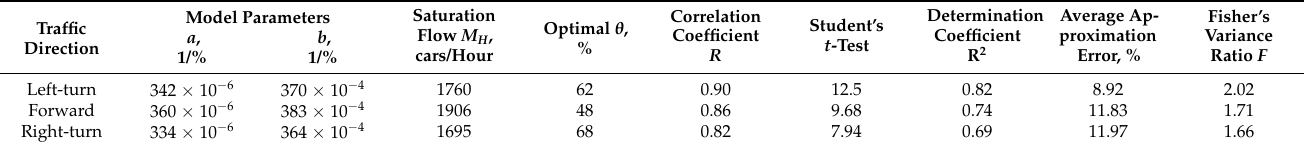
Table 2. Results of experimental studies to determine the parameters of the model (1) and verify its